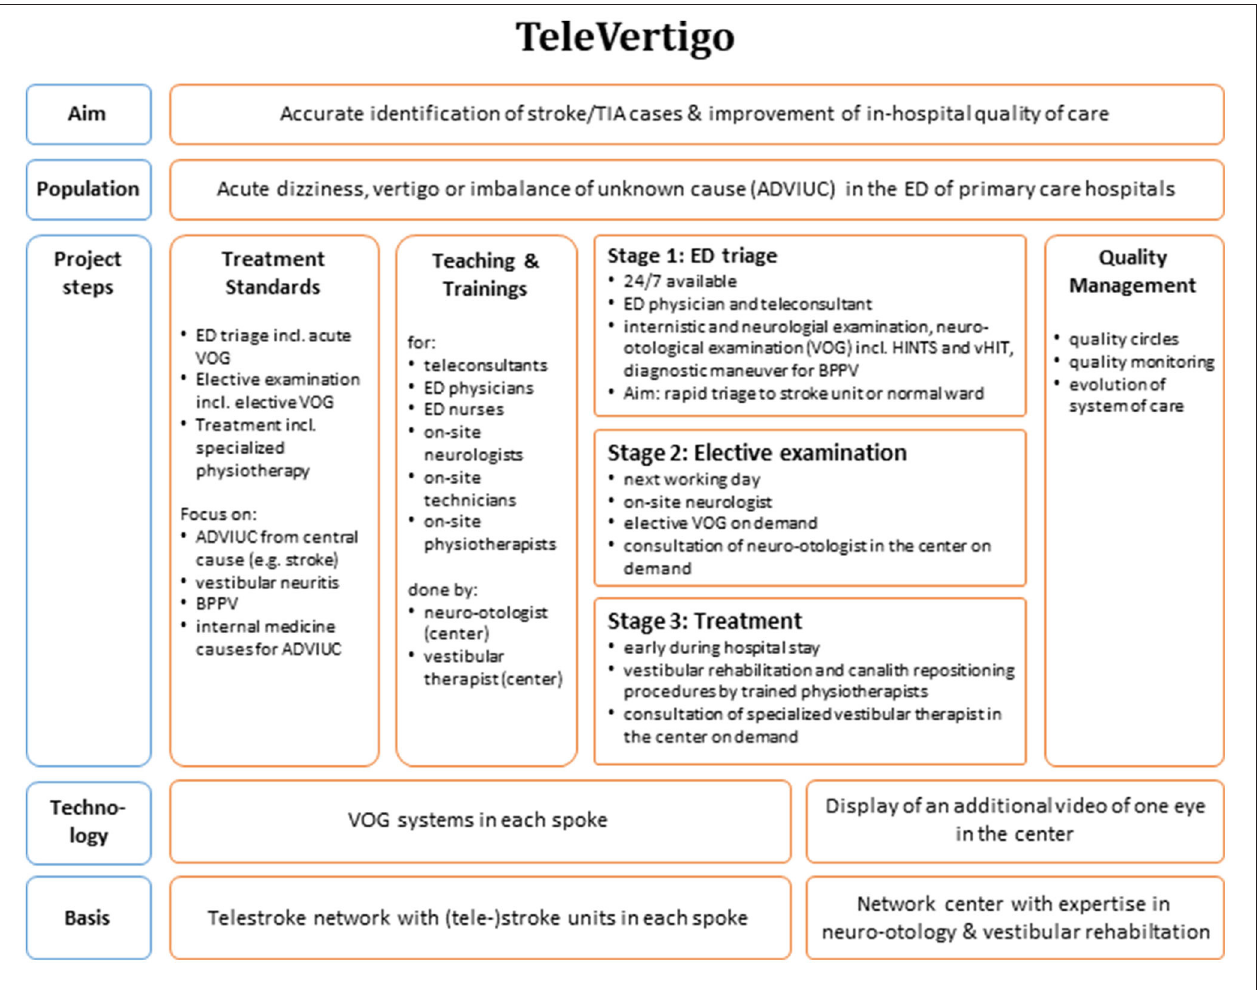
FIGURE 2 | Overview of the major components of the TeleVertigo project.